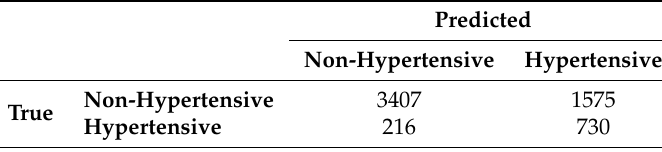
Table 11. Confusion matrix.